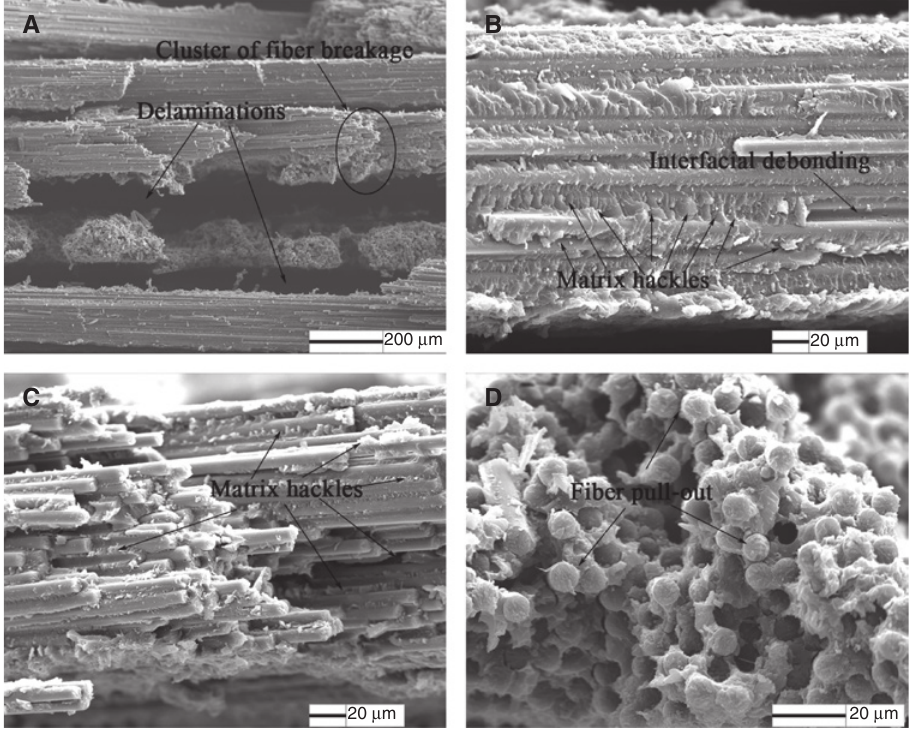
Figure 9: Microstructure of different layers in carbon/benzoxazine composite specimen precured for 30 min at 80 ° C after fracture by SEM: (A) [90 ° /45 ° /0 ° /-45 ° ] , (B) 0 ° , (C) 45 ° and (D) 90 ° 3